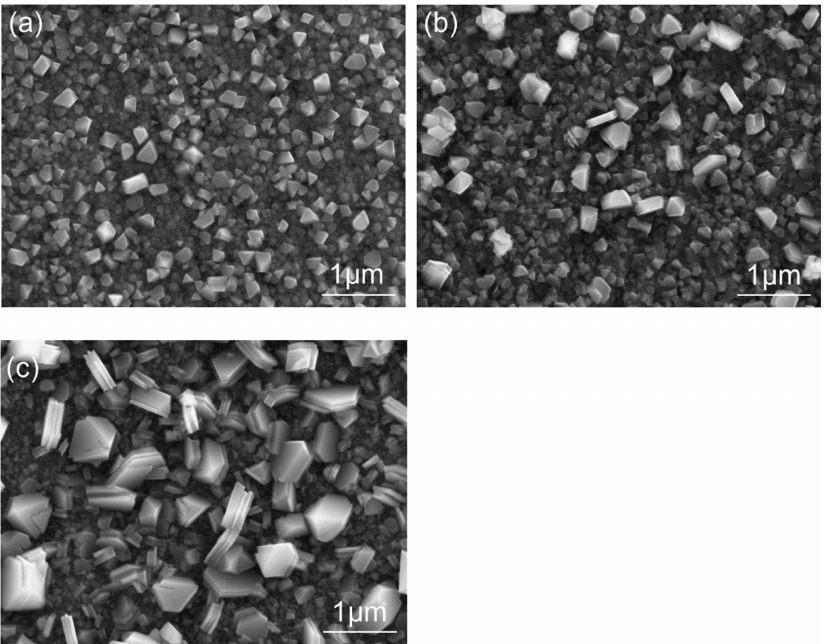
Figure 3: SEM morphologies of the oxide films on 304 stainless steel without (Fe, Cr)Sn 2 adhesion after exposure to 300°C water for various periods (a) 24 h (b) 240 h, (c) 480